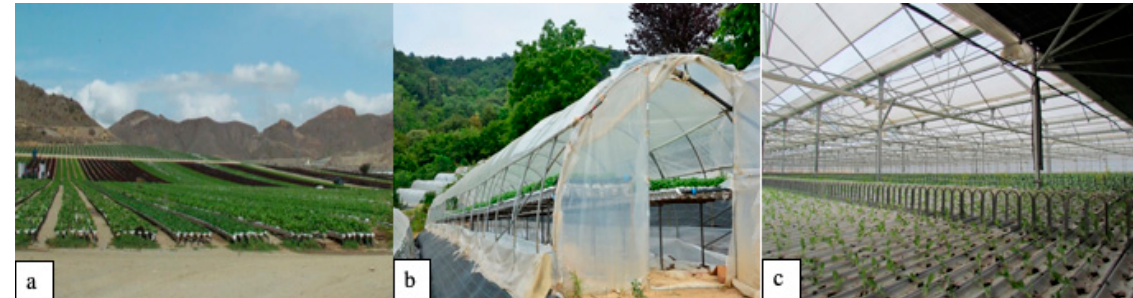
Figure 1. ( a ): View of the New Growing System (NGS ® ) used commercially in open fields in Pulpí, Almería, Spain. ( b ): NGS ® adopted on a smallholding farm. ( c ): View of a fully automated and mobile NGS ® adopted on a large farm.